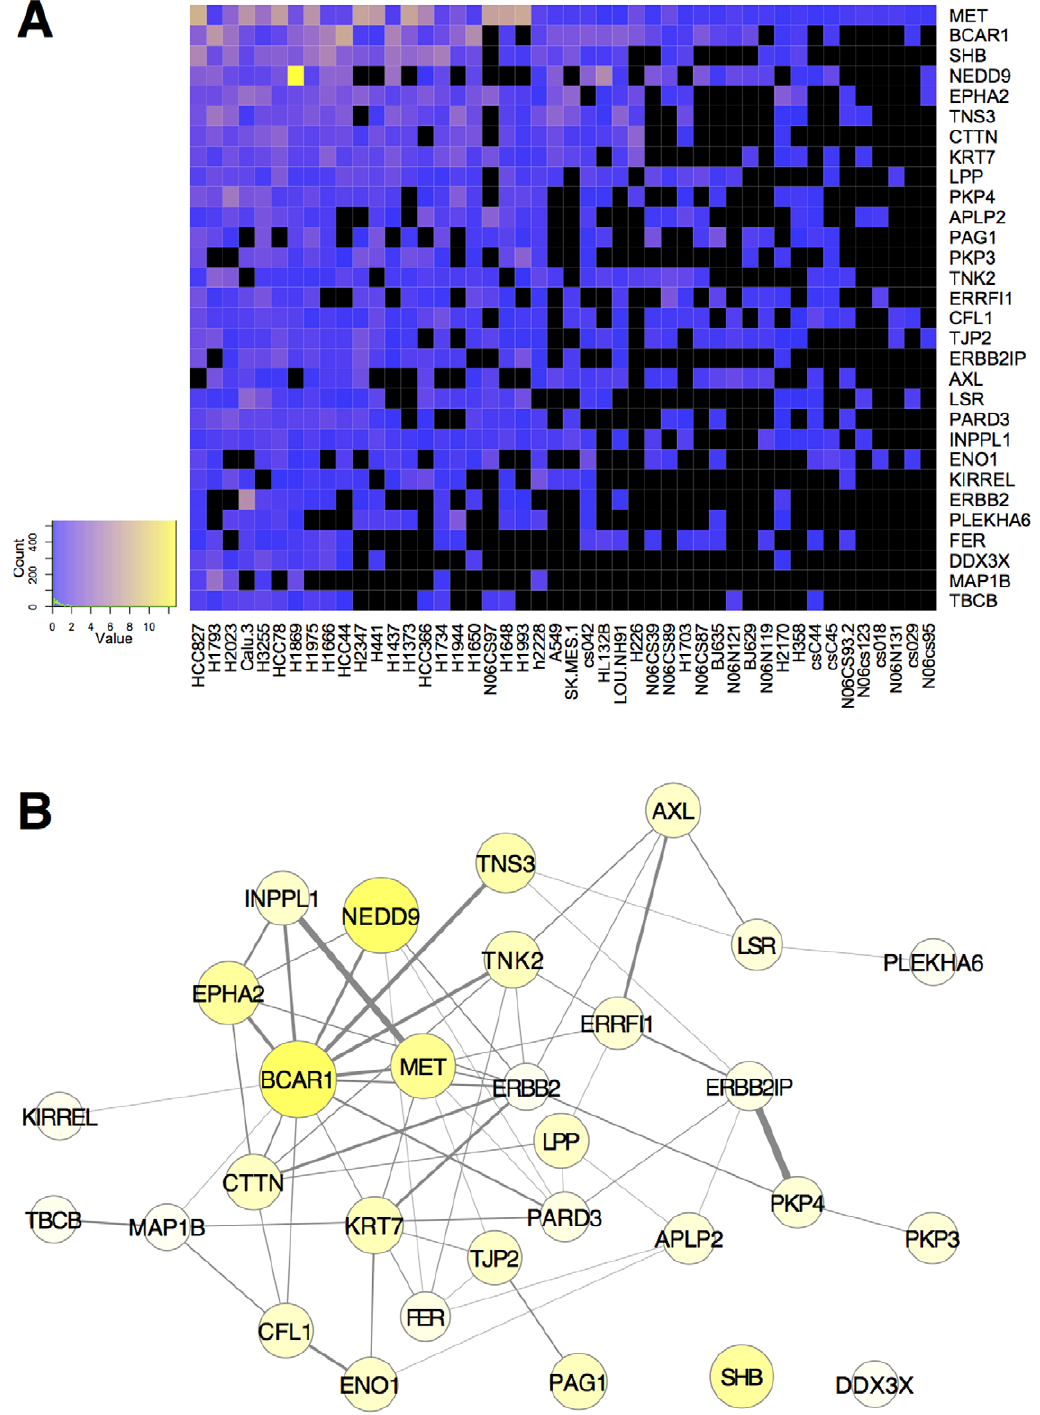
Figure 4. Filtered cluster containing MET derived from first performing t-SNE Spearman and Euclidean embedding separately, then combining these clusters and filtering for samples containing MET and the most highly represented proteins that are consistent with data in the rest of the cluster ( see Materials and Methods ) . The heat map ( A ) represents missing data (NA) as black, and increasing scaled peptide counts are shown on a blue-yellow scale (color key, left). Data are ordered by decreasing sums of scaled peptide counts for genes (decreasing from top to bottom) and samples (decreasing from left to right). B ) MET in lung cancer shown as a protein-interaction network graphed as in Figure 3. This cluster had 70-fold more edges, 847-fold greater edge weight, five-fold more GO terms retrieved than the average random cluster, and 249 more edges than would be expected from these nodes from the entire lung cancer network.